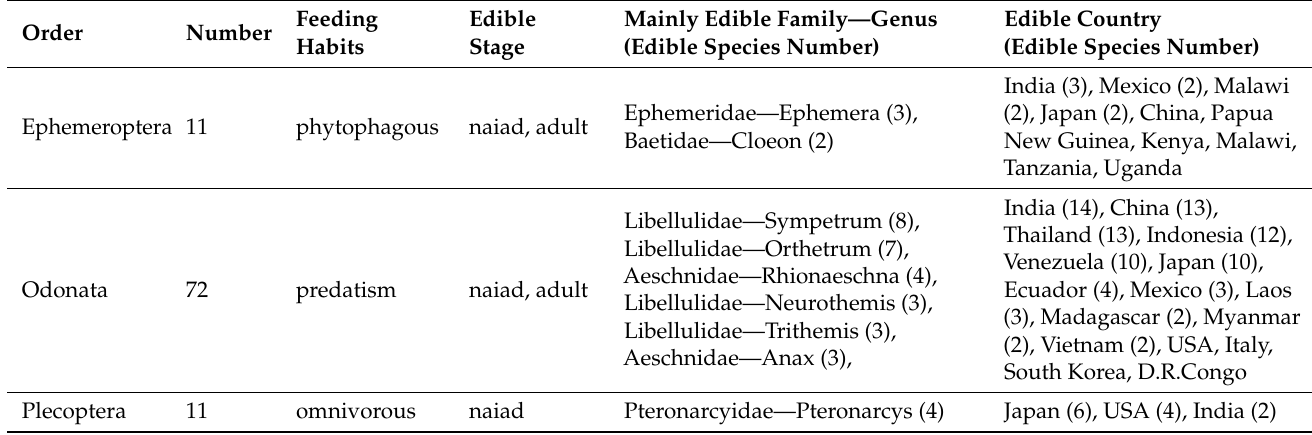
Table 1. The species information of edible aquatic